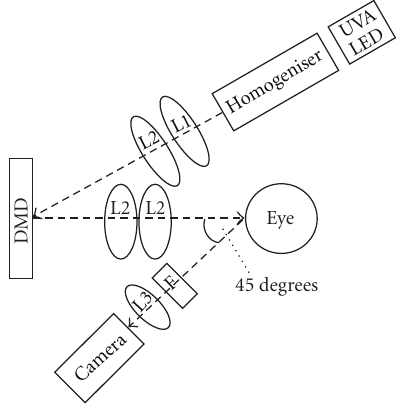
Figure 1: Block diagram of bench top DMD system